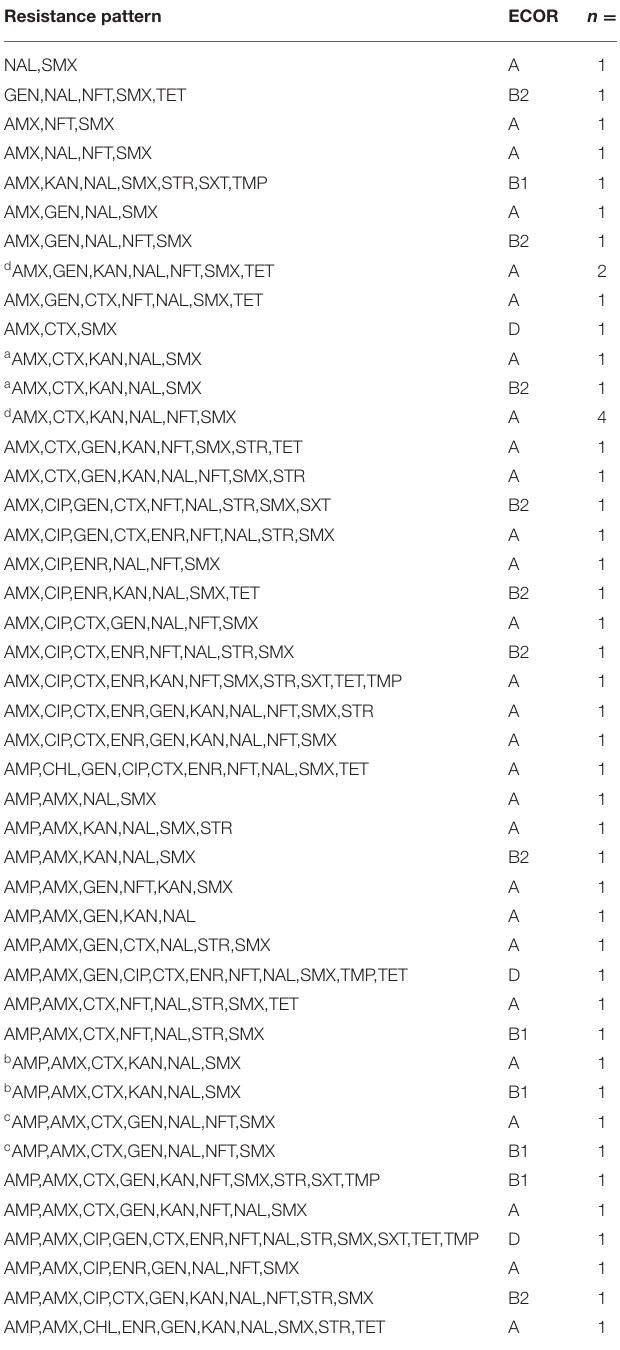
TABLE 3 | Antibiotic resistance patterns of aEPEC strains from the NRL collection with their phylogenetic groups (ECOR). Resistance pattern ECOR n =